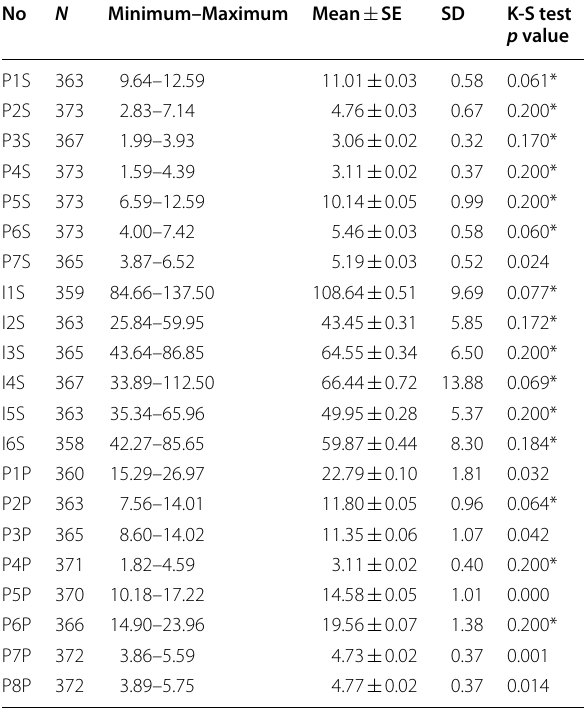
Table 6 Descriptive statistics for parameters and indexes of pelvic and sacral